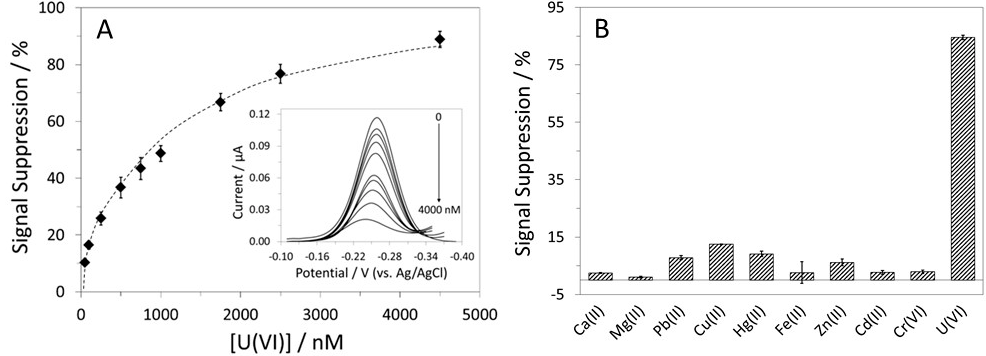
Figure 4. ( A ) Calibration curve for the U-pT-12 sensor and (inset) the resultant ACVs. ( B ) The responses of the sensor to nine metal ions and U(VI), each at a concentration of 4 µM. To determine the U-pT-12 sensor’s specificity for U(VI), we analyzed its responses to nine other metal ions: Ca(II), Mg(II), Pb(II), Cu(II), Hg(II), Zn(II), Fe(II), Cr(VI), and Cd(II) (Figure 4B). Among the tested metal ions, Pb(II), Cu(II), and Hg(II) were found to cross-